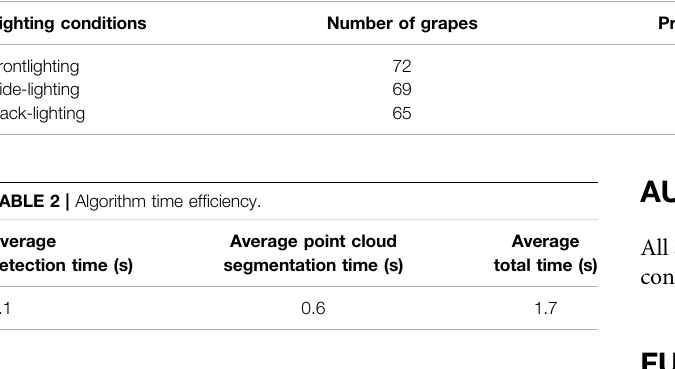
TABLE 1 | Precision, recall, and IOU of the proposed model.